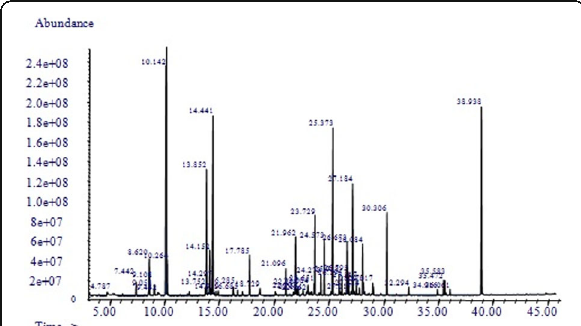
Fig. 1 Peak marked with retention time. The result of GC-MS analysis of the compound essential oil, the main components were showed as the marked peak with retention